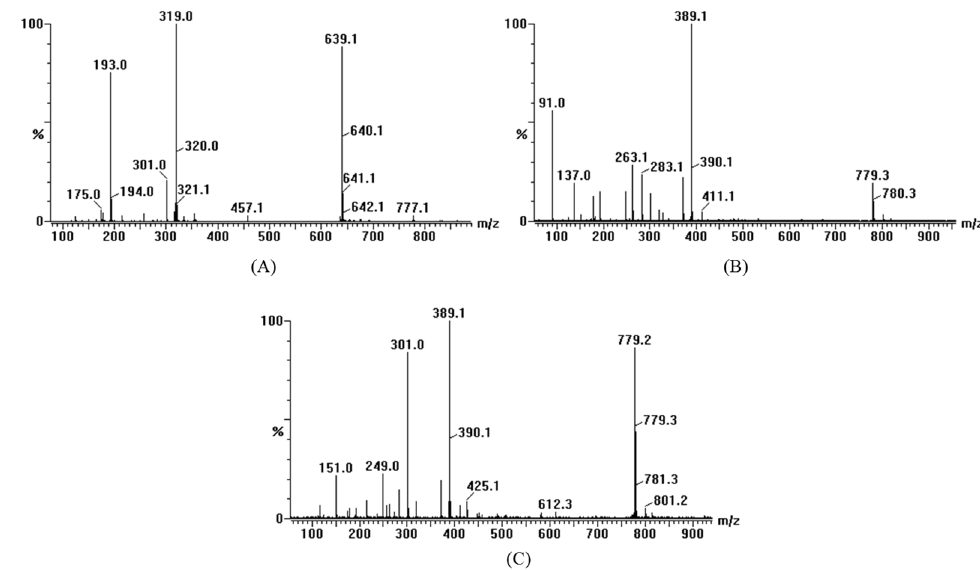
Figure 2. LC-MS spectrogram: ( A ) DHM; ( B ) product 1; ( C ) product 2.